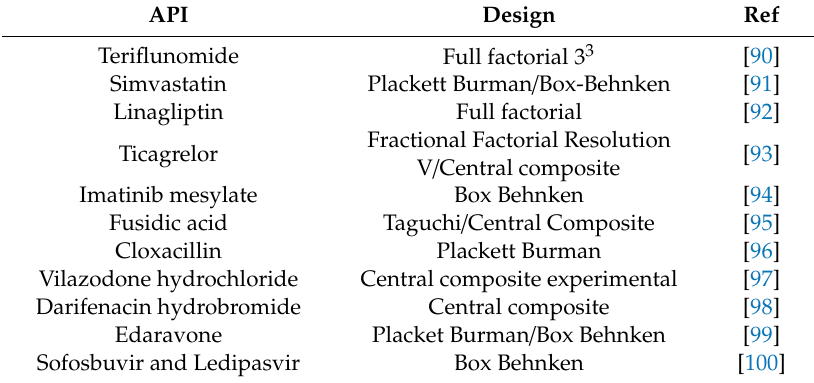
Table 5. Design of experiments used in some papers to optimize chromatographic conditions for analyses of degradation products.